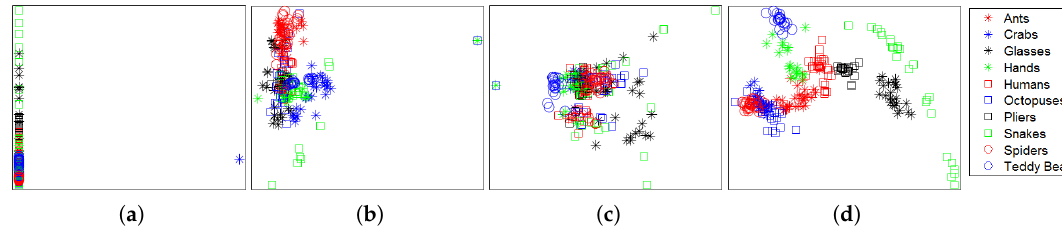
Figure 5. 2D PCA projection of shape descriptors computed from: ( a ) original Shape-DNA; ( b ) cShape-DNA; ( c ) GPS; and ( d ) LESI algorithms on McGill